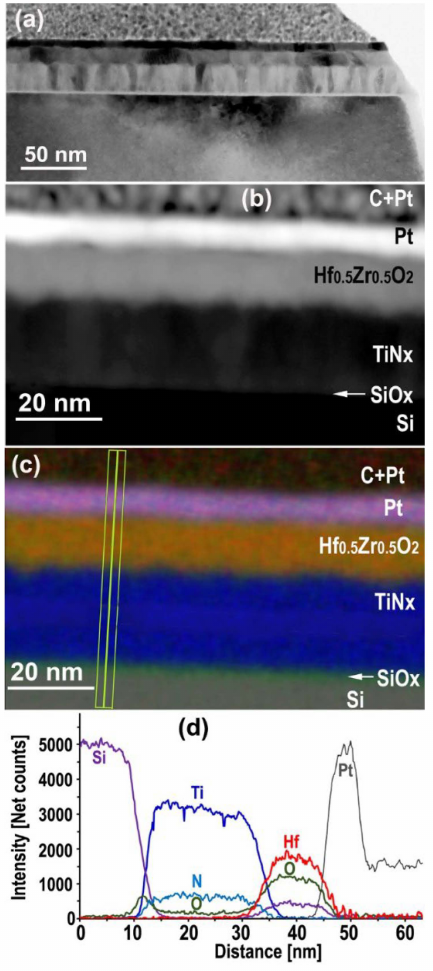
Figure 2. MIM structure on Si substrate with 1.5 nm native SiO x : Overall view of TEM bright field cross section ( a ), HAADF STEM image ( b ) and corresponding EDXS elements map with transverse line scans ( c ), Ti, N and O net counts transverse profiles along the line scan ( d ).